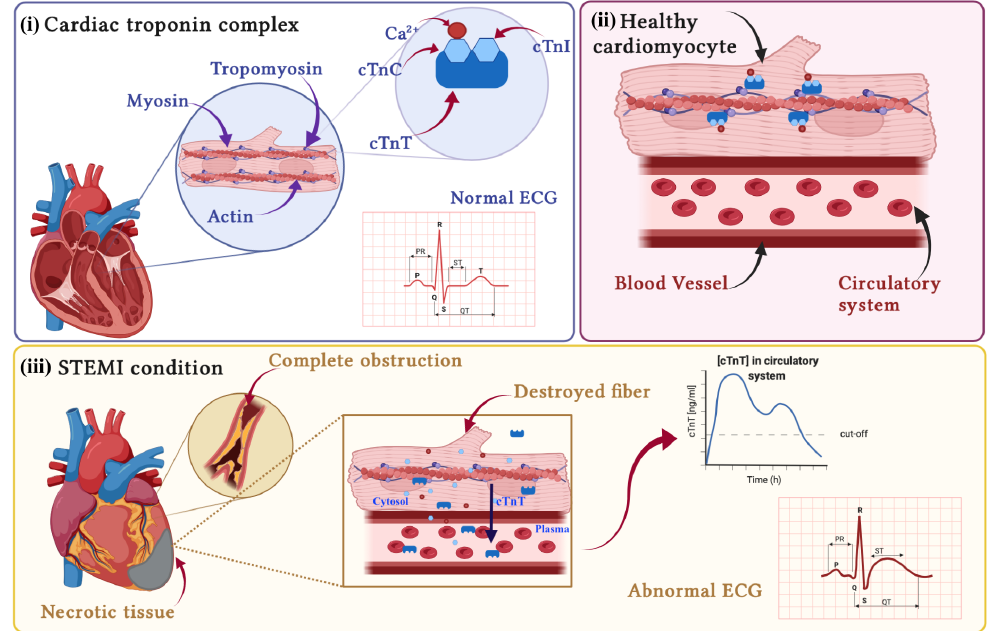
Figure 1. (i) Cardiac troponin complex is composed of three different protein subunits, each of which has a specific role in cardiac contraction: (1) subunit C, designed to bind the Ca 2 + , (2) subunit I, binds to actin in thin myofilaments, and (3) subunit T, connected to tropomyosin. (ii) In a typical healthy cardiomyocyte, all the fibers appear intact, and none of the three cardiac troponin subunits is appreciably detectable in the systemic circulation. (iii) During an AMI, the myocardial tissue downstream of the vascular obstruction goes into necrosis: the myofibers disintegrate and the cellular membrane breaks down, allowing components of the troponin complex to reach the circulatory system. Several abnormalities can be observed on ECG tracings. Among them, an elevation in the ST segment, especially during the initial phase of an AMI, is associated with a larger clinical risk, suggesting complete coronary obstruction. This type of AMI is called STEMI (ST-elevation myocardial infarction) and requires prioritized management, being associated with a higher risk for mortality and clinical complications, especially in the absence of timely restoration of blood flow to the infarcted